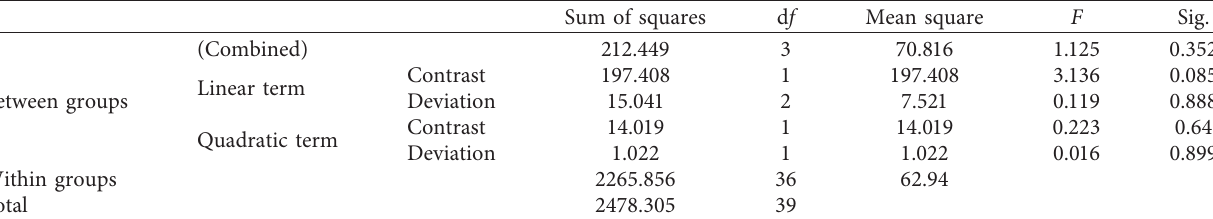
Table 7: ANOVA test with mean square and sum of squares.